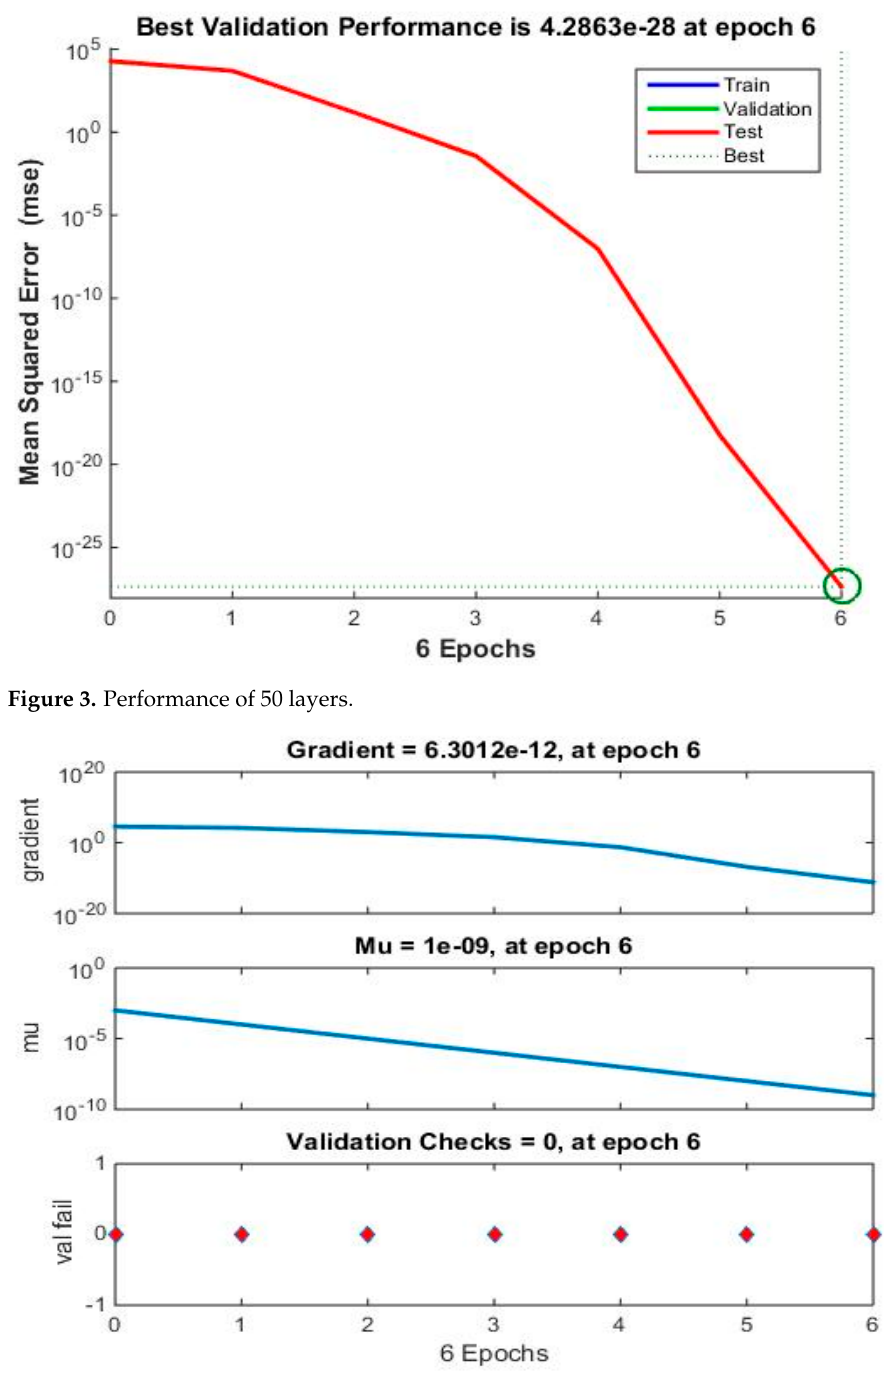
Figure 4. Training state of ANN model.